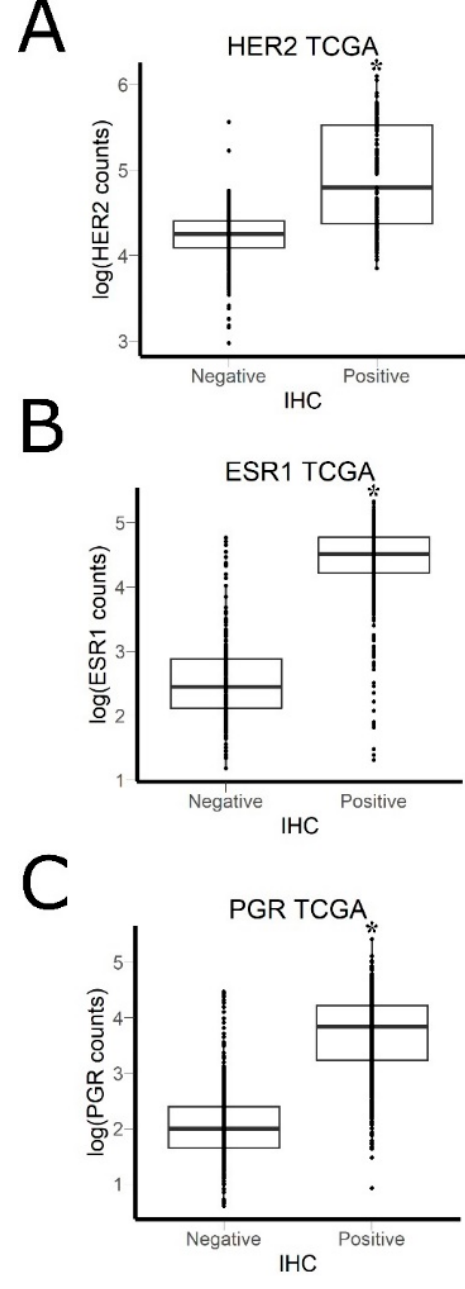
Figure 7. IHC results vs. mRNA level measured by NGS RNA sequencing in The Cancer Genome Atlas (TCGA) data: ( A ) HER2: area under the receiver-operator curve (AUC = 0.82); ( B ) ESR1: area under the receiver-operator curve (AUC = 0.96); ( C ) PGR: area under the receiver-operator curve (AUC = 0.92). * p -value < 2.2 × 10 − 16 (Wilcoxon rank-sum test). Table3.